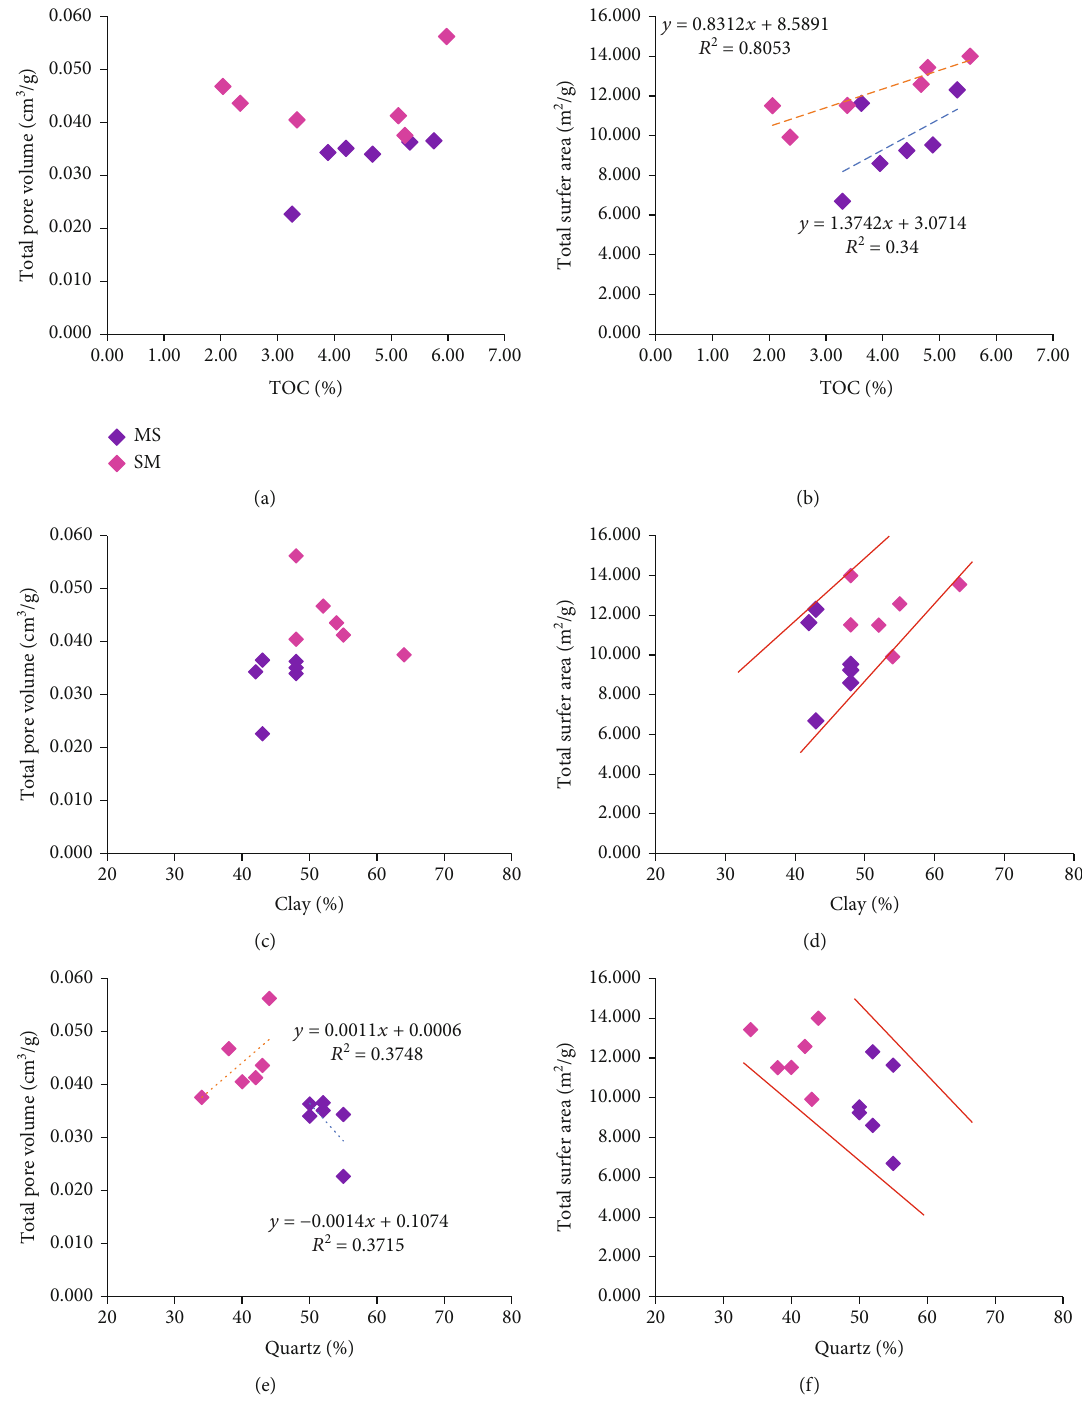
Figure 10: Relationships between total pore volume and TOC (a), total surfer area and TOC (b), total pore volume and clay (c), total surfer area and clay (d), total pore volume and quartz (e), and total surfer area and quartz